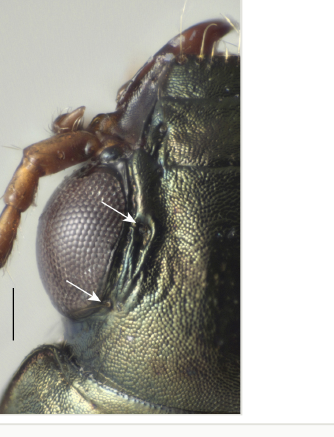
Figure 3. Bembidion ambiguum , left side of head. The base of the two supraorbital setae are indicated by the arrows. Scale bar is 0.1 mm.